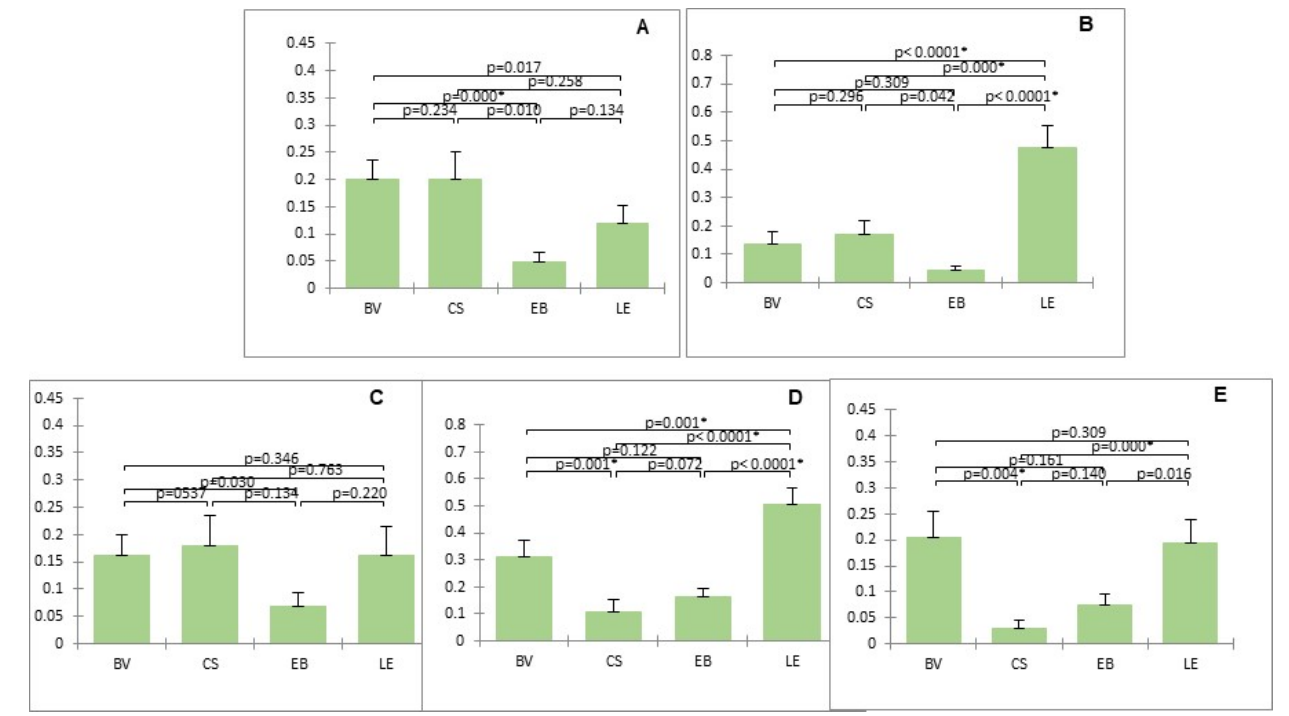
Figure 1. Fruit internal defects (mean ± standard error): flesh bruising ( A ), stem end rot ( B ), flesh discoloration ( C ), vascular browning ( D ), and body rot ( E ). * p -value with the “*” mean that there is a statistically significant difference between orchards ( p < 0.05) .